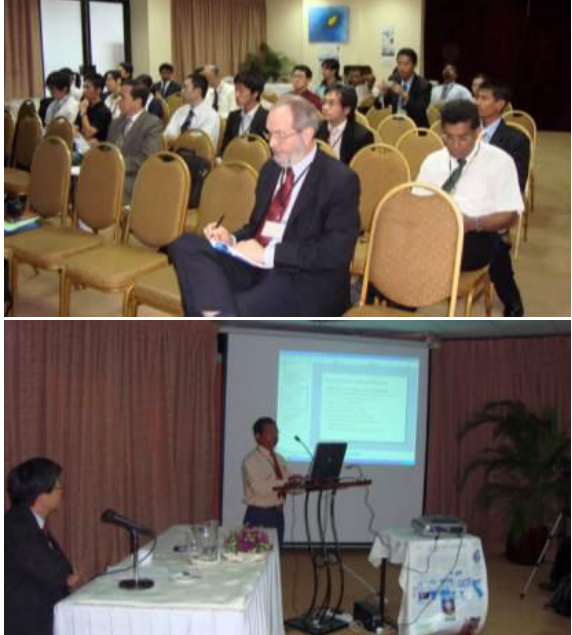
Figure 1. Student Session at the ACRS 2008